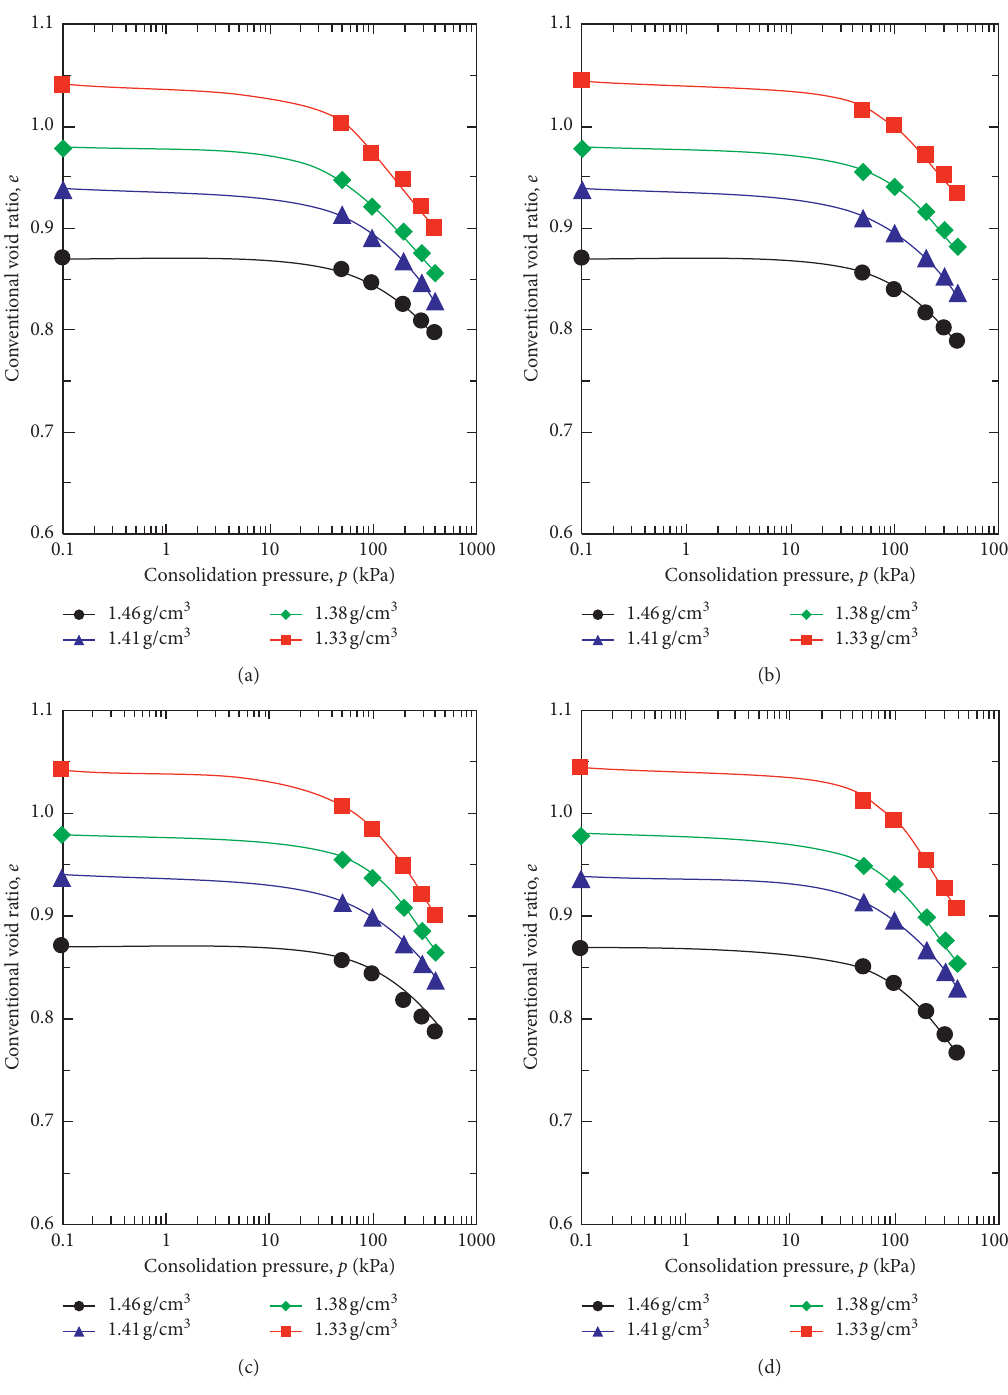
Figure 9: Compressive behavior of the unsaturated MH soil with different water contents and dry densities. (a) Water content 34.0%. (b) Water content 32.0%. (c) Water content 29.4%. (d) Water content